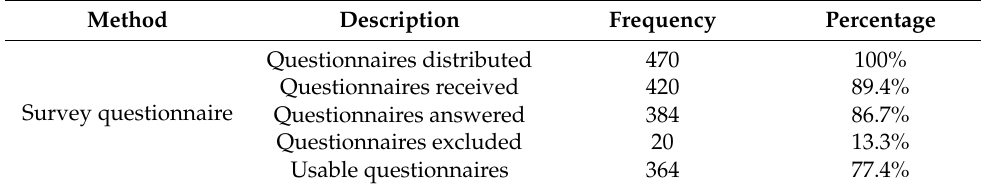
Table 1. Response rate obtained from the data collected through survey questionnaires.